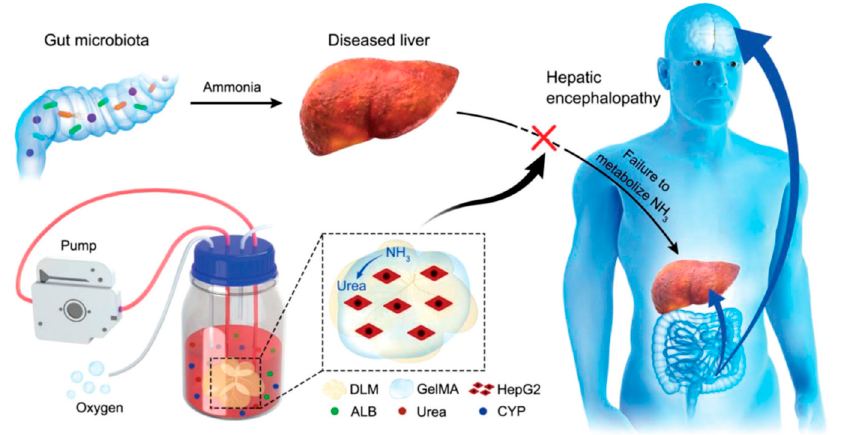
Figure 2. New bio-artificial liver devices development